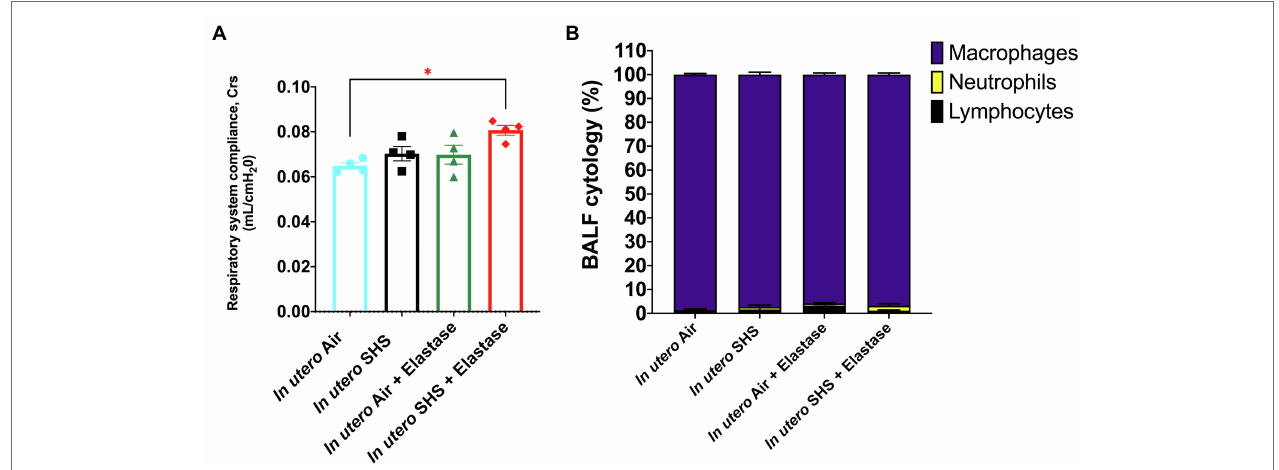
FIGURE 2 | In utero SHS plus adult elastase increased the respiratory system compliance without affecting BALF cytology 28 days after elastase treatment. (A) Respiratory system compliance (Crs) measured using a FlexiVent system at 15 weeks of age in female mouse offspring. N = 4 per group; data are expressed as